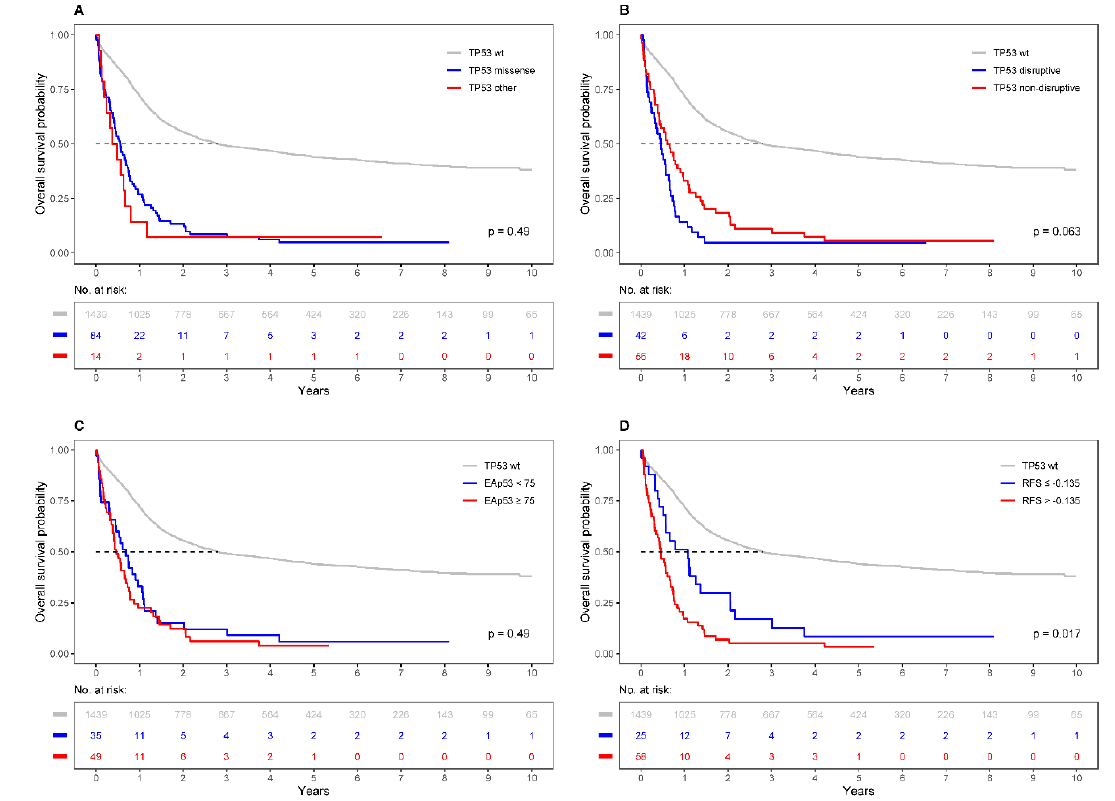
Figure 1. Overall survival (OS) probabilities for patients with TP53 -mutated AML according to functional mutation scoring systems. ( A ) comparison of missense TP53 mutations versus other types of aberration (nonsense and splice site mutations, insertions and deletions). ( B ) comparison of disruptive versus non-disruptive TP53 mutations. ( C ) classification according to the “Evolutionary Action p53 Score”. ( D ) classification based on the “Relative Fitness Score” (RFS) with the AML-specific threshold of −0.135 showing a statistically significant survival difference (median OS, 12.9 versus 5.5 months). All P -values refer to the comparison of TP53 -mutated groups. Abbreviation: wt, wild type. Table 2. Median overall survival rates of AMLSG patients with and without TP53 -mutated acute myeloid leukemia (AML) and with respect to TP53 -specific functional scoring systems.